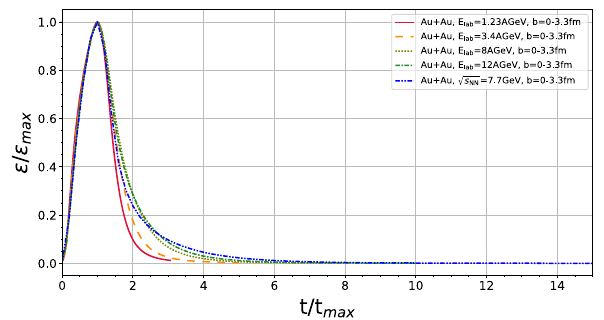
Fig. 2 Time evolution of the energy density ε in the center of the system for Au+Au collisions, 0–5% centrality class, at E lab = 1.23, √ s NN = 7.7 GeV, normalized to the value at its 3.4, 8, 12 AGeV and maximum ε max and rescaled to the corresponding time t max